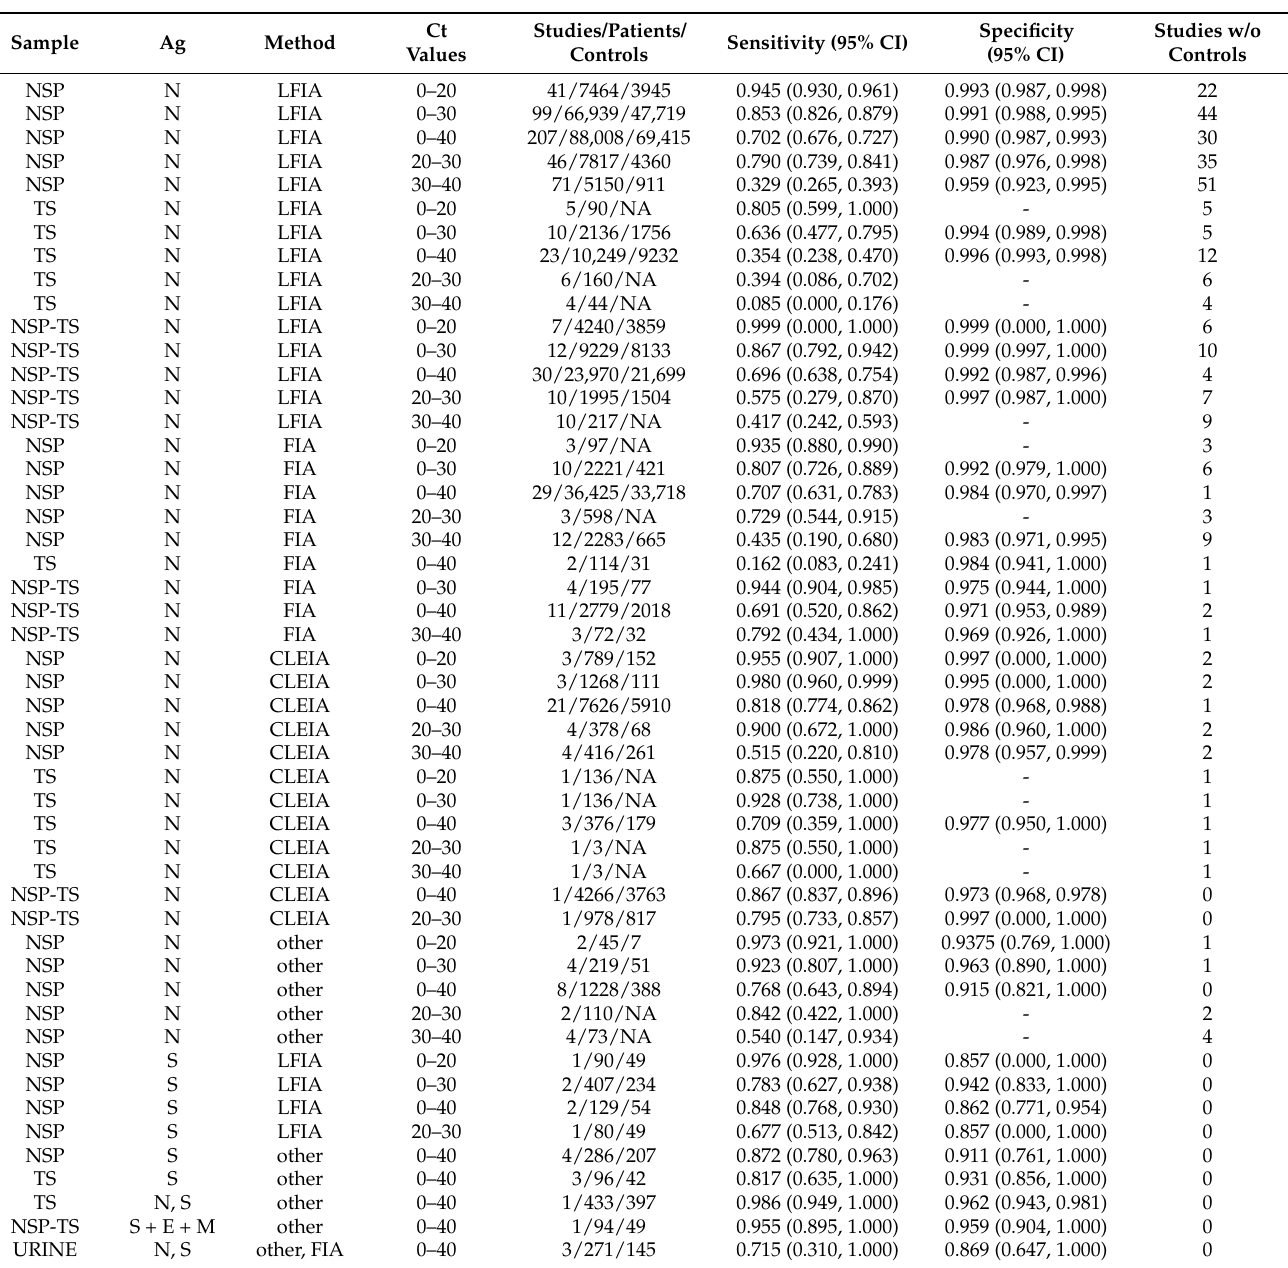
Table 2. Results of the multivariate meta-analysis for the different types of assays using different samples and stratified according to different cut-off rt-PCR values. Listed information includes the pooled sensitivity and specificity along with the 95% confidence intervals (NSP: pharyngeal, nasopharyngeal, nasal specimens, TS: throat, saliva, N: nucleocapsid protein, S: spike protein, M: membrane E: envelope, NS: nucleocapsid and Spike